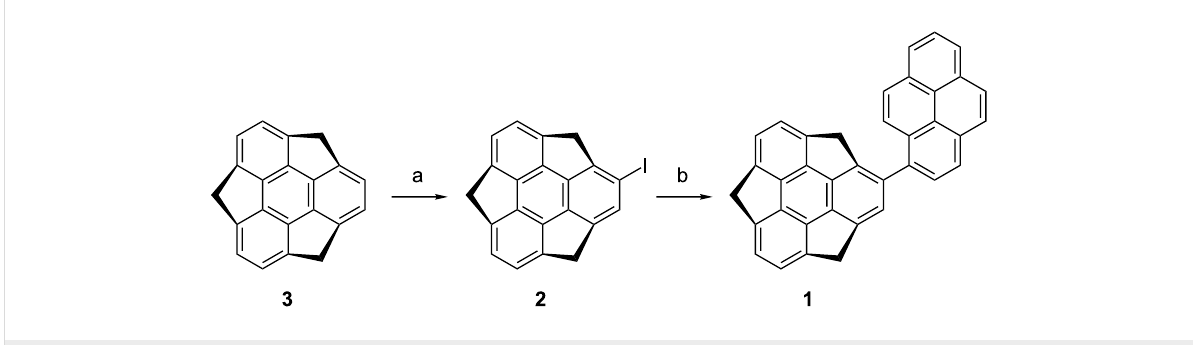
Scheme 1: Synthesis of pyrenylsumanene ( 1 ): (a) Sc(OTf) 3 (5 mol %), DIH (100 mol %), CH 2 Cl 2 , rt, 2.5 h, yield 80%; (b) palladium (II) acetate (20 mol %), 1-pyreneboronic acid (150 mol %), acetone/water 4:1, 40 °C, 12 h, yield 84%.